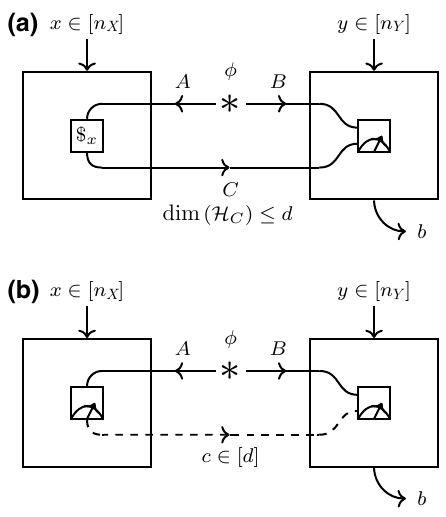
FIG. 2. (a) The general channel. When Alice and Bob share an entangled state φ , Alice encodes her classical input x into a d -dimensional message c by applying a quantum channel $ x . Depending on his classical input y , Bob performs a joint measurement { M b | y } b on Alice’s message and his share of the entanglement and produces an outcome b . (b) The quantum-to- classical channel. When the communication is classical, Alice performs a POVM { M c | x } c and relays the outcome c to Bob. Bob’s operation can be viewed as a POVM { M b | y , c } y , c condi- tioned on his classical input y and Alice’s message c